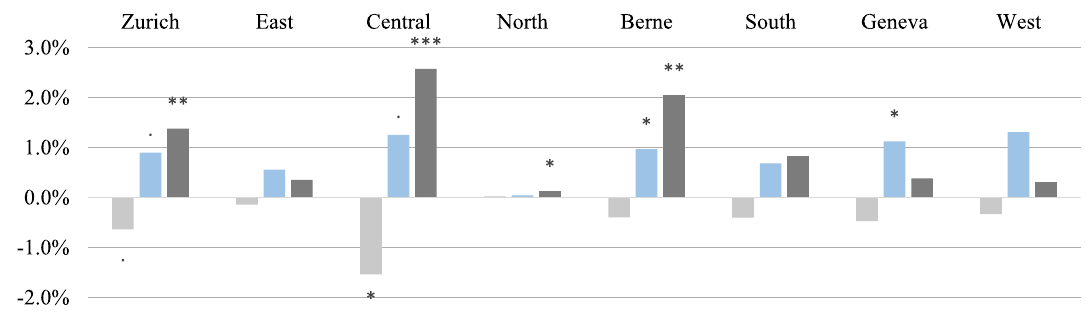
Fig. 9 Commercial real estate—interest rate effect across Swiss monitoring regions. Notes: Displayed coefficients correspond to yields on governmental bonds with 10-year maturity for each monitoring region in Switzerland. The coefficients are the results of a fixed-effect panel regression capturing 106 Swiss MS-regions between 2005 Q1 and 2018 Q4 (56 quarters) analogous to the baseline regression model in Table 3 model 1. Signif. codes: “***” 0.001, “**” 0.01, “*” 0.05, “.”